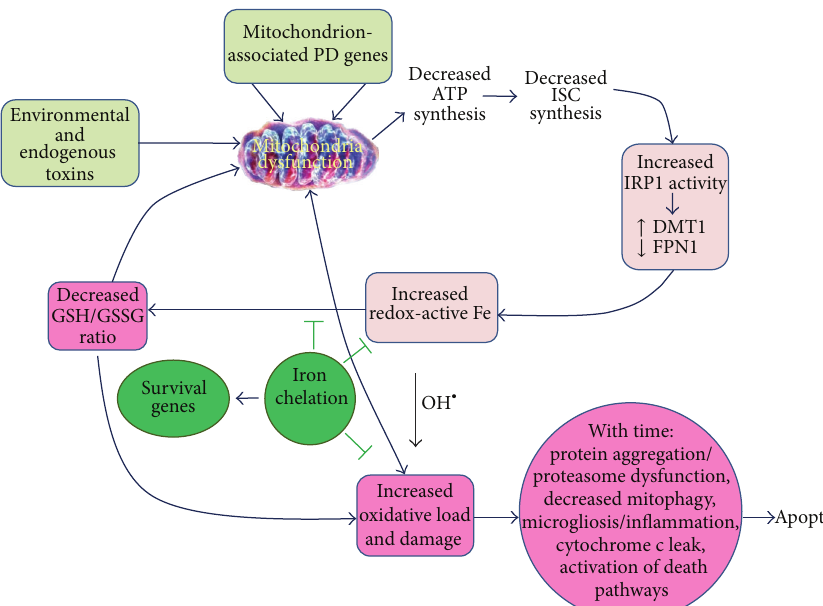
Figure 3: Mitochondrial dysfunction leads to iron accumulation and cell death. Mitochondrial dysfunction in PD, caused either by environmental or endogenous toxins or by genetic dysfunctions, results in decreased ATP and ISC synthesis. The lack of ISCs results in a false low iron signal and the spurious activation of IRP1. Activation of IRP1 results in increased redox-active iron levels mediated by increased expression of DMT1 and TfR1 and decreased expression of FPN1. Because of hydroxyl radical generation through the Fenton reaction, increased redox-active iron results in a decreased GSH/GSSG ratio and an increased oxidative load. The decrease in GSH further affects mitochondrial activity. With time, the increased oxidative load induces protein aggregation and saturation of the ubiquitin-proteasome system, further mitochondrial dysfunction, an inflammatory microenvironment, increased cytochrome c leak, and activation of death pathways. Iron chelation has been demonstrated to slow this cycle by decreasing iron-associated oxidative damage and by induction of cell survival and cell-rescue pathways. Environmental and endogenous toxins: paraquat, rotenone, MPTP, nitric oxide, 4-hydroxynonenal, advanced glycation end products, and aminochrome. Mitochondria-associated PD genes with mitochondrial dysfunction component: 𝛼 -Syn, Parkin, PINK1, DJ-1, LRRK2, and